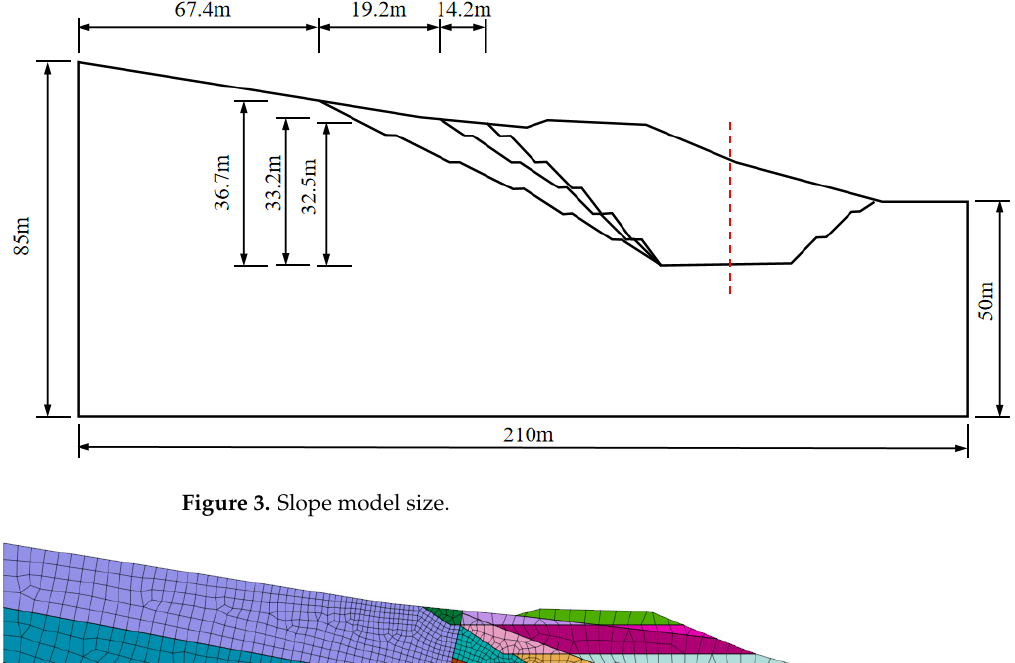
Figure 3. Slope model size.